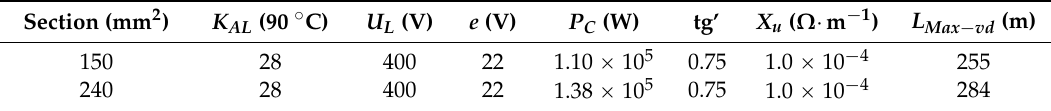
Table 6. Voltage drop. Results of Equation